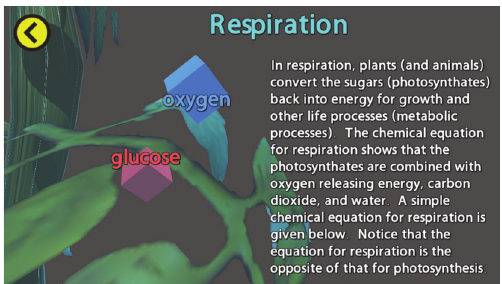
Figure 24: Respiration scene.